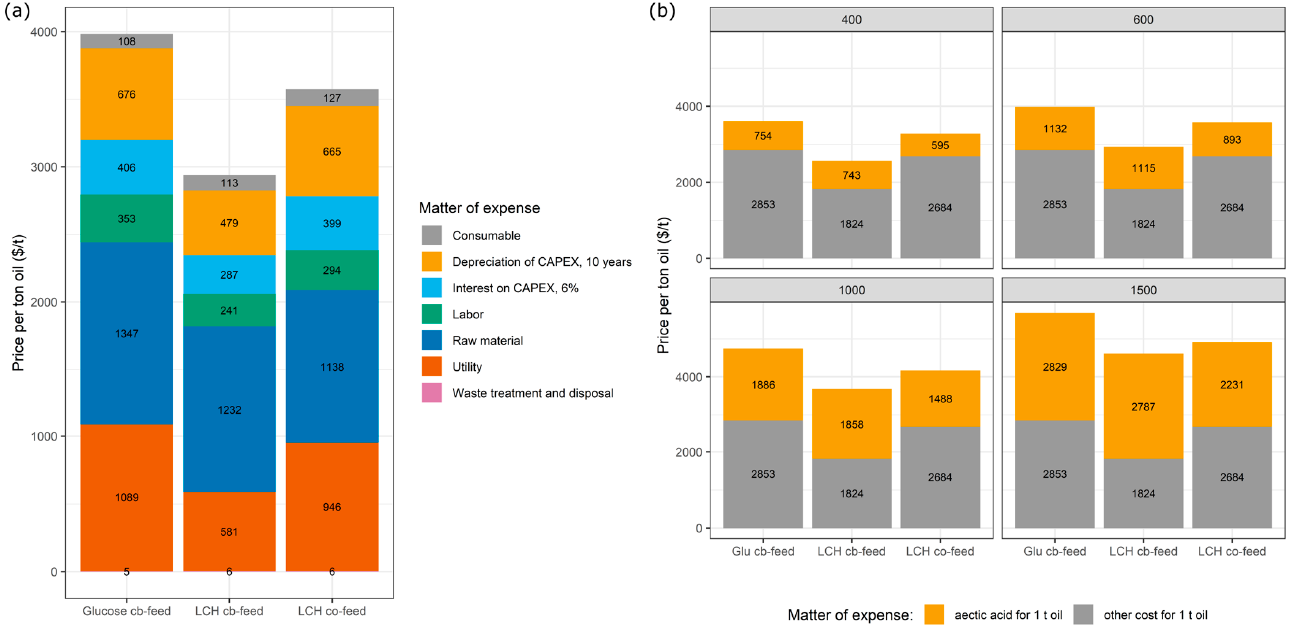
Figure 4. ( a ) Annual production cost of yeast oil in USD/Mt for the three fermentation strategies analyzed with the TEA. The respective amount of feedstock was set to produce yeast oil at a rate of 0.81 Mt/h (LCH cb-feed: 1 Mt/h, glucose cb-feed: 0.151 Mt/h, LCH co-feed: 2.1 Mt/h). ( b ) Annual production costs in a sensitivity analysis of the influence of the acetic acid prices 400, 600, 1000, and 1500 USD/t. LCH—lignocellulosic hydrolysate; cb-feed—consumption-based acetic acid feed; co-feed—lignocellulosic hydrolysate as starting carbon and constant feed with cb-feed.